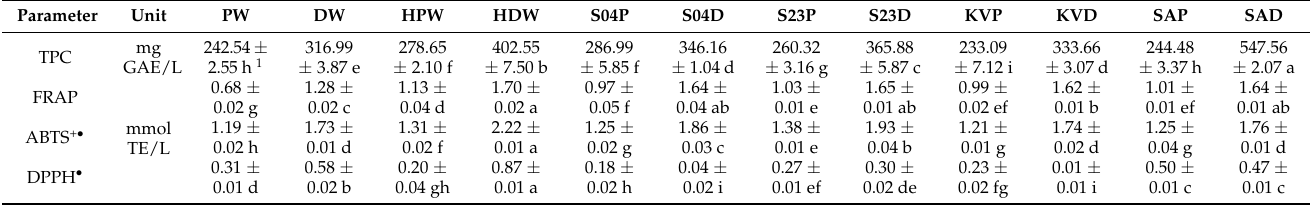
Table 3. Total phenols content (TPC) and antioxidant activity (FRAP, ABTS + • , DPPH • ) of worts and